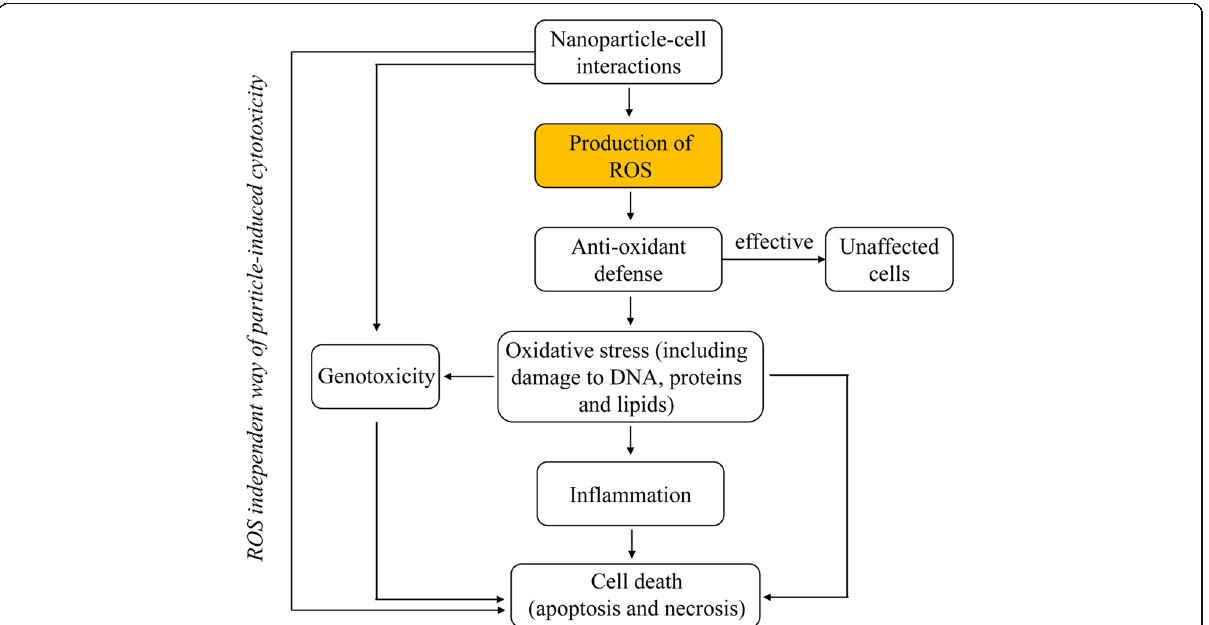
Fig. 2 The crucial role of ROS in the cytotoxicity induced by NPs [33]. The possible cellular events taking place after NPs interact with intracellular